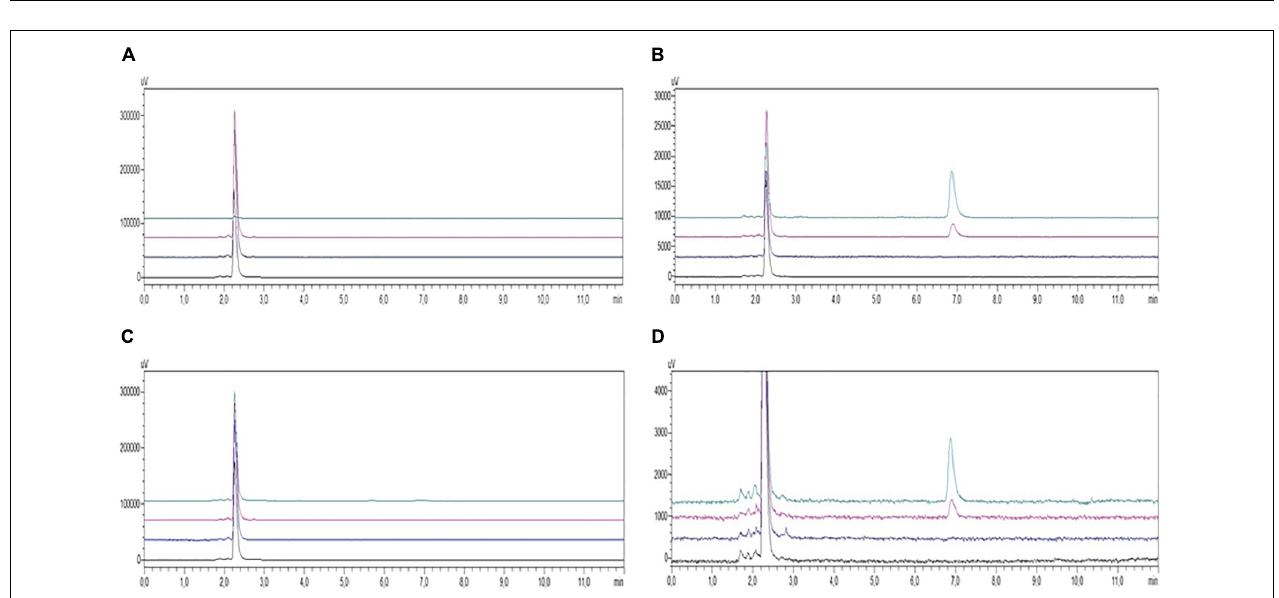
FIGURE 3 | Cell viability. Cell viability was assessed by Trypan Blue exclusion test. PBMCs (Peripheral blood mononuclear cells) were treated with COMPOUND 1 at 0.001–10 µ M (A) , with amyloid beta (B) , with both COMPOUND 1 and amyloid beta (C) , and the Time Course for all three treatments (D) .